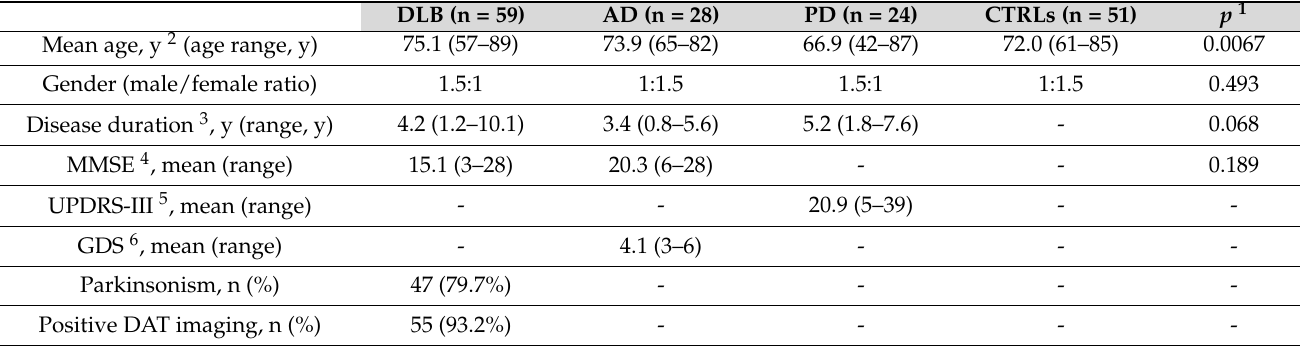
Table 1. Demographic and clinical data of the participants of the